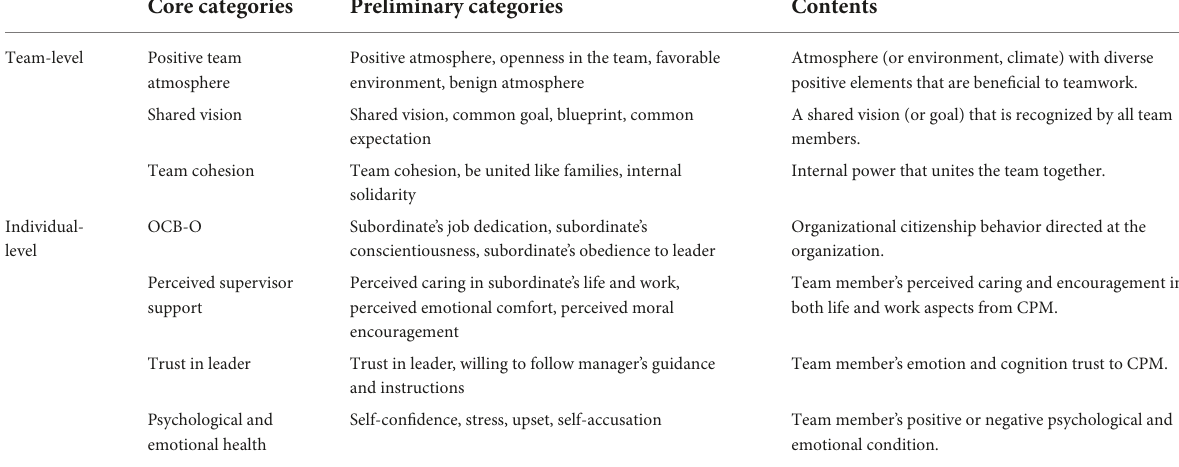
TABLE 2 The emergence of core